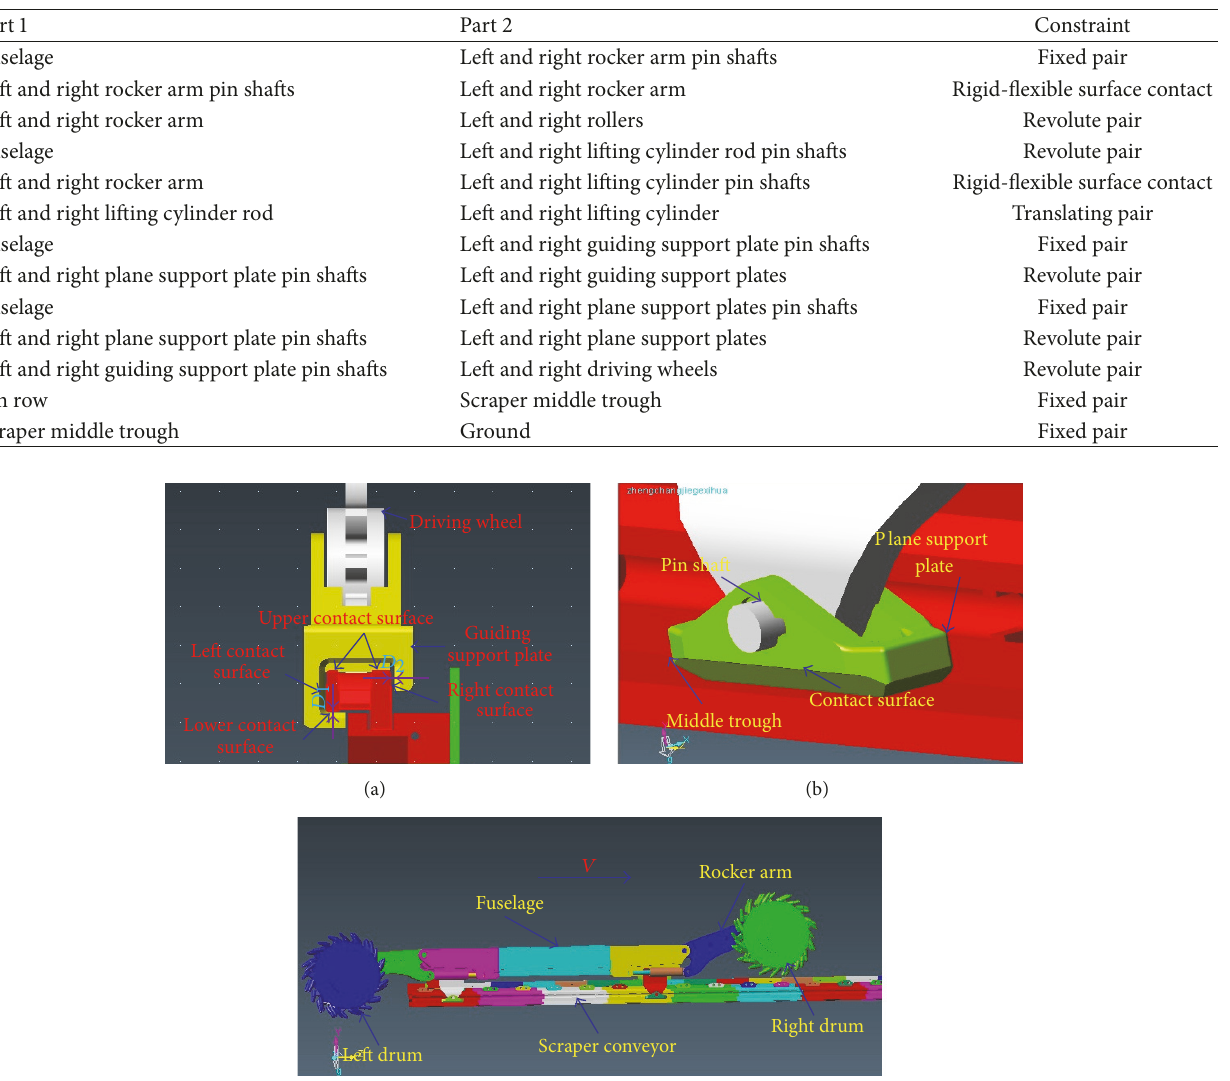
Table 1: Motion constraints.